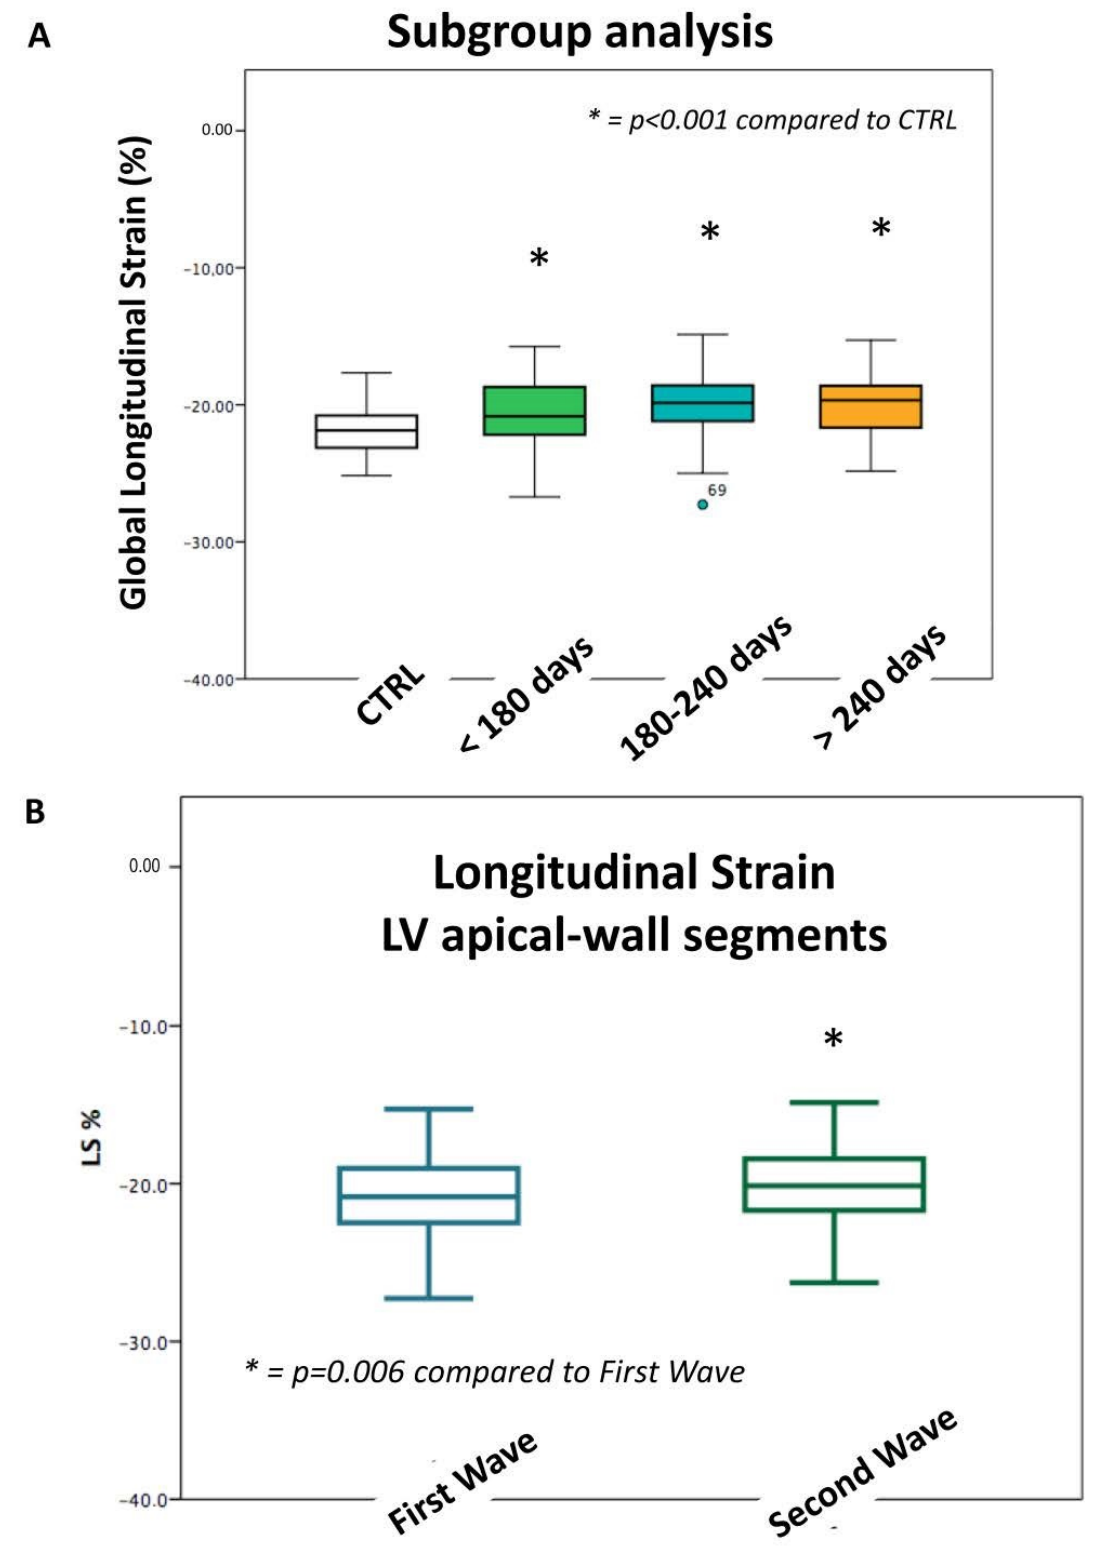
Figure 3. Longitudinal strain of the post-COVID-19 group according to different follow-up ( A ) and different pandemic waves ( B ).